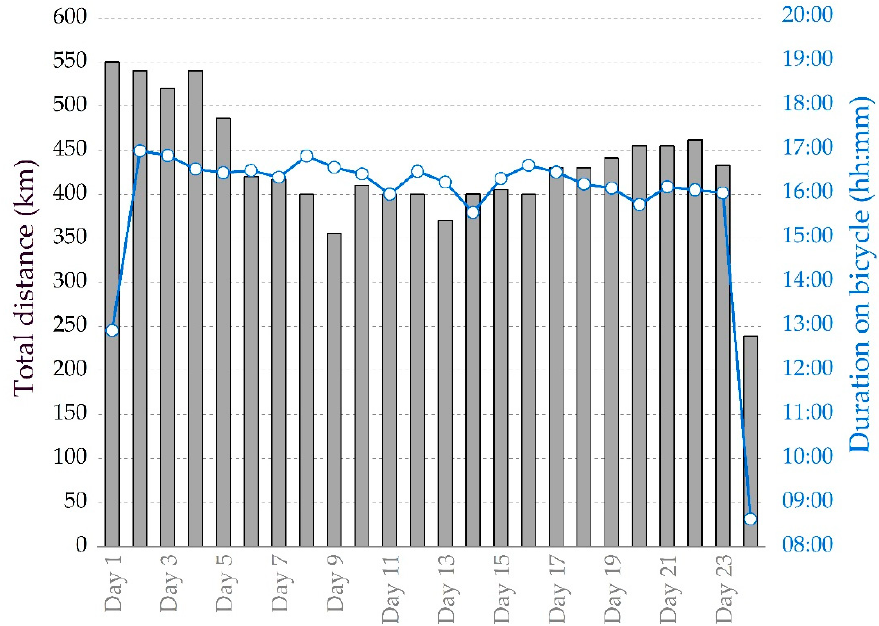
Figure 1. Progression of daily total distance and duration on bicycle over the duration of the 24-day tour.